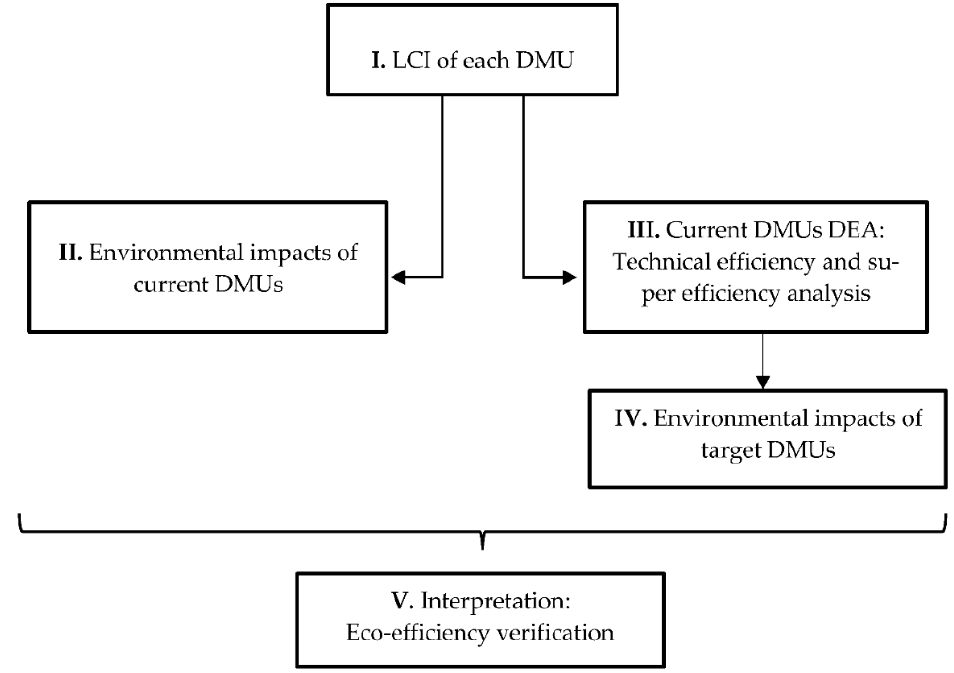
Figure 2. Five-step LCA + DEA methodology for wheat production.